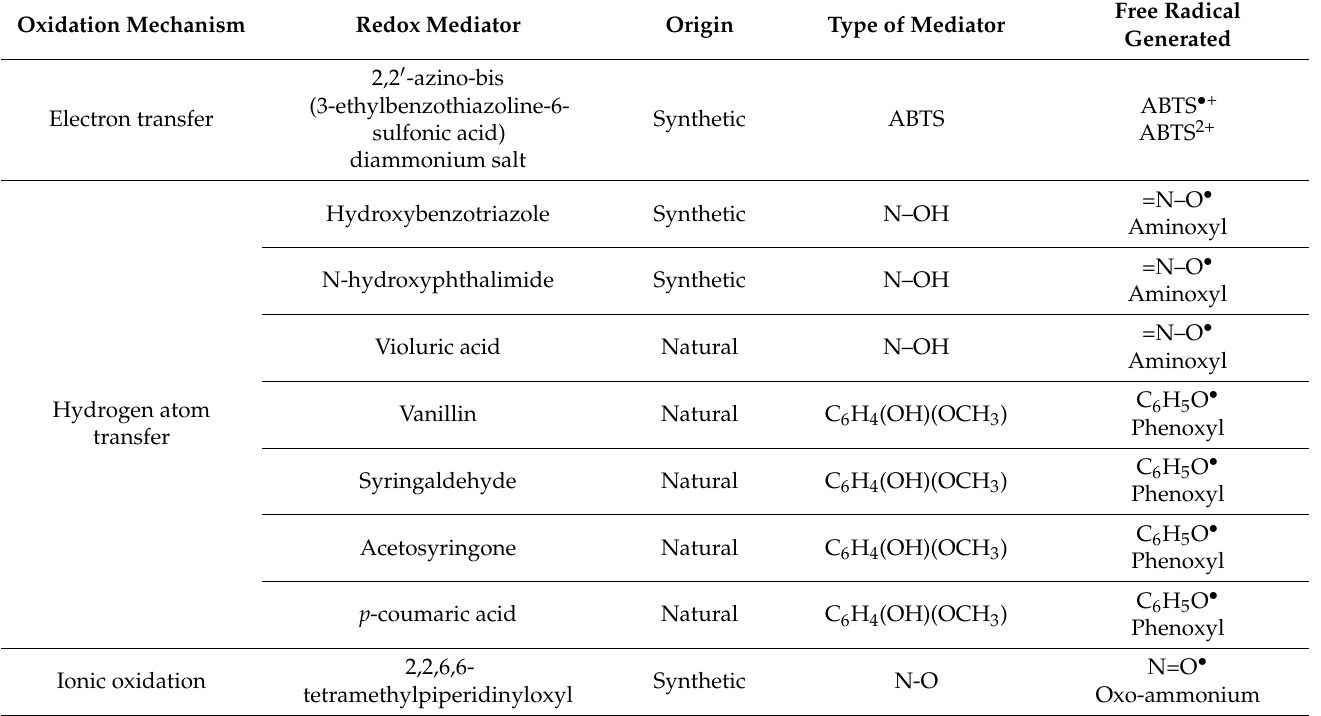
Table 2. Characteristics of redox mediators used in treatment of micropollutants by Lac-mediator systems.